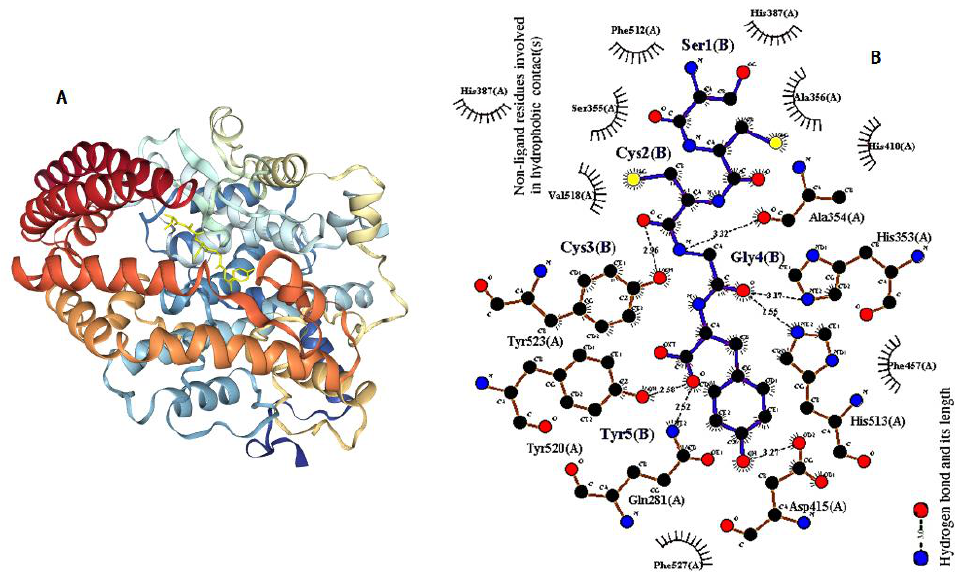
Figure 3. Binding of the representative oligopeptides to angiotensin - converting enzyme and the interacting residues, angiotensin - converting enzyme and SCCGY ( A , B ). The crystal structure of angiotensin - converting enzyme (ACE) (PDB code: 2XY9) was obtained from the PDB database, which was docked to the oligopeptides generated by in silico hydrolysis using HPEPDOCK software (http://huanglab.phys.hust.edu.cn/hpepdock, accessed on 5 March 2022).